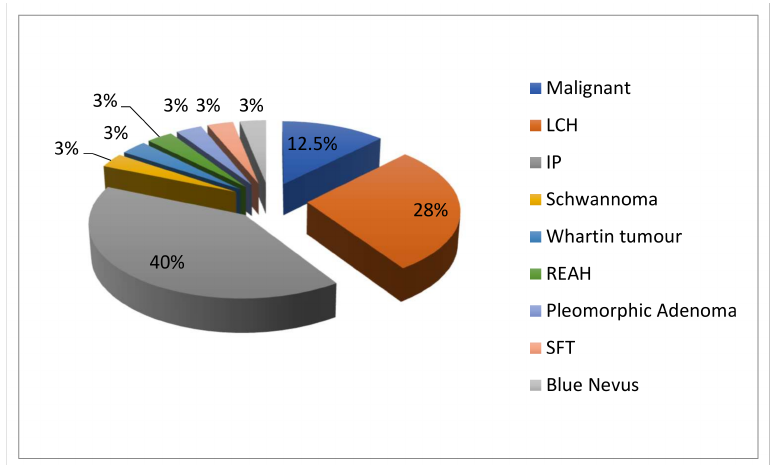
Figure 1. Pie chart that highlights the percentages of the different tumours of our series. LCH: Lobular capillary haemangioma; IP: Inverted Papilloma; SFT: solitary fibrous tumour; REAH: Sinonasal respiratory epithelial adenomatoid